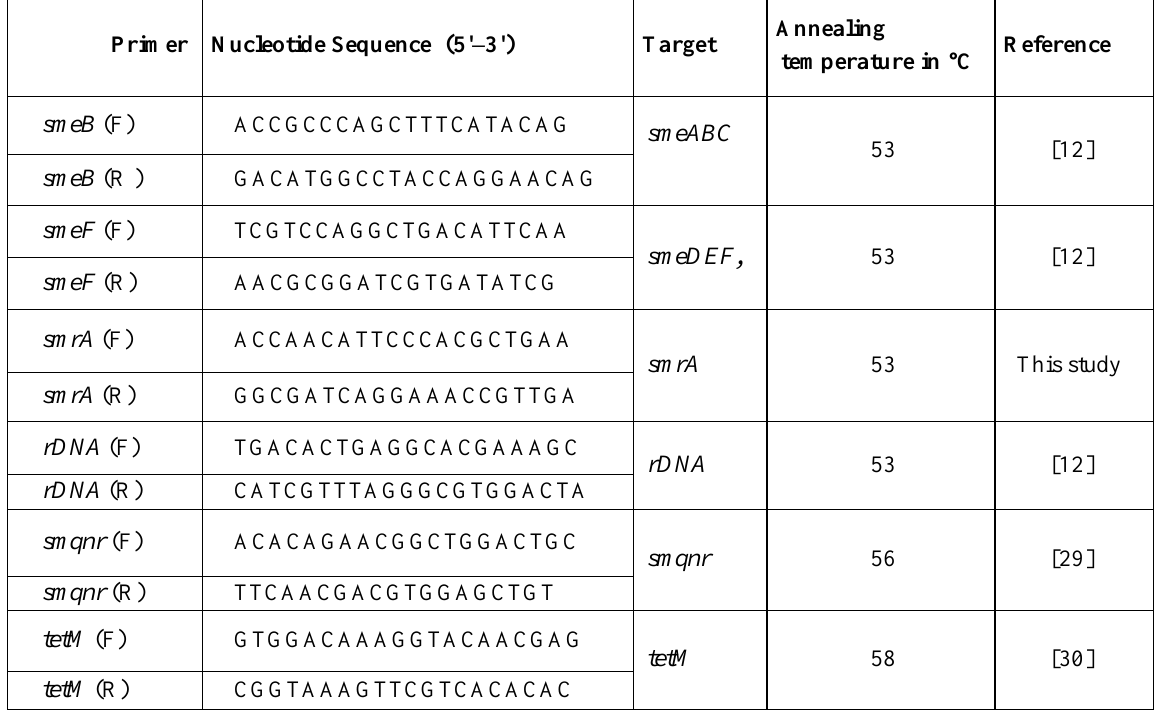
Table 1. Primers used in this study.